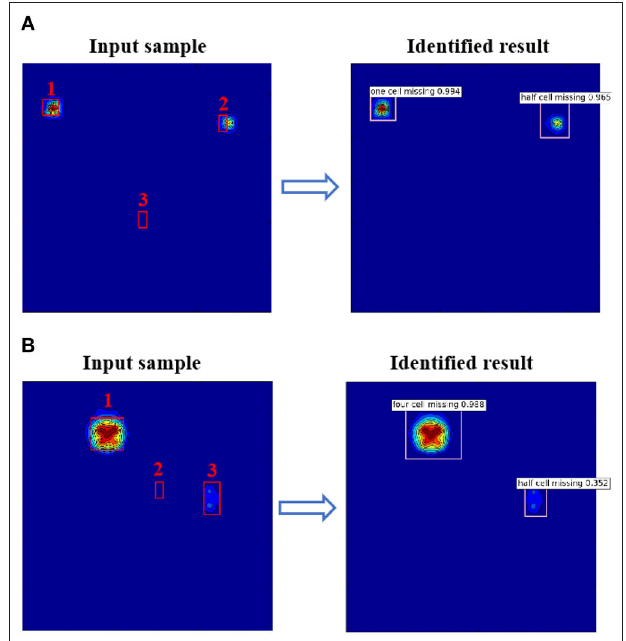
FIGURE 10 | Examples of DI-1. (A) Case 1 and (B) case